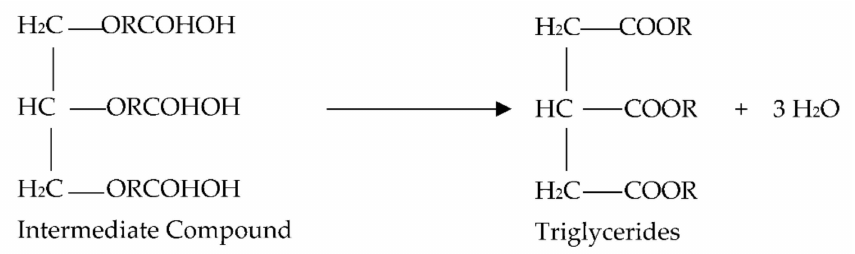
Figure 7. A schematic representation of the glycerolysis reaction fourth